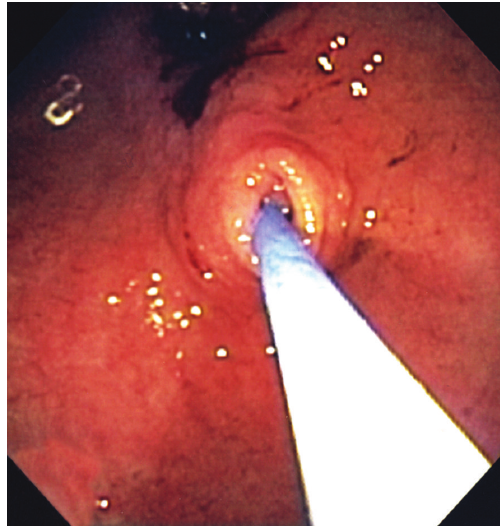
Figure 2: Endoscopic gastroduodenoscope showing opening in prepyloric web after probing with the tip of the heater probe.